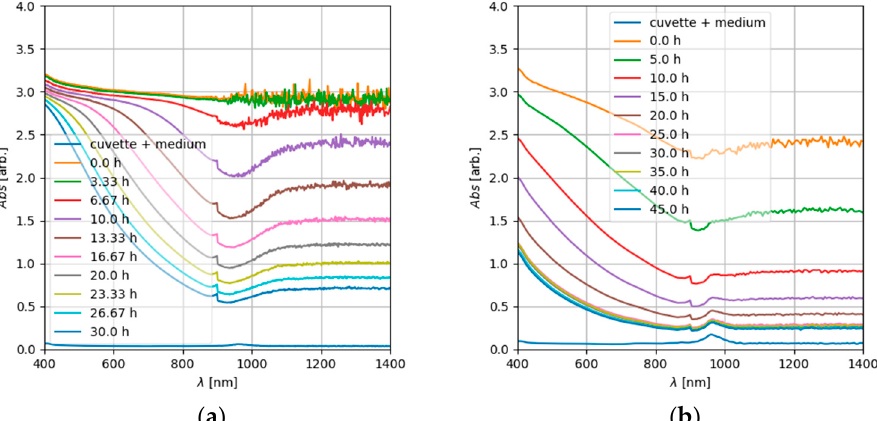
Figure 8. Time series of the UV-Vis spectra of NM110 TiO 2 dispersed in cell culture medium (treat- ment; see Section 2.2) at a concentration of c 0 = 2.56 mg/mL ( a ) and 0.256 mg/mL ( b ); the lowermost spectrum is from the cuvette and the medium without particles.